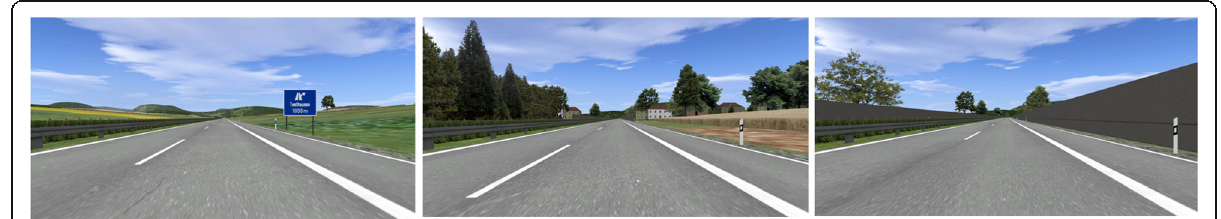
Fig. 2 Exemplary illustration of the route - cross-country (left) - rural (centre) - through town with noise protection (right)